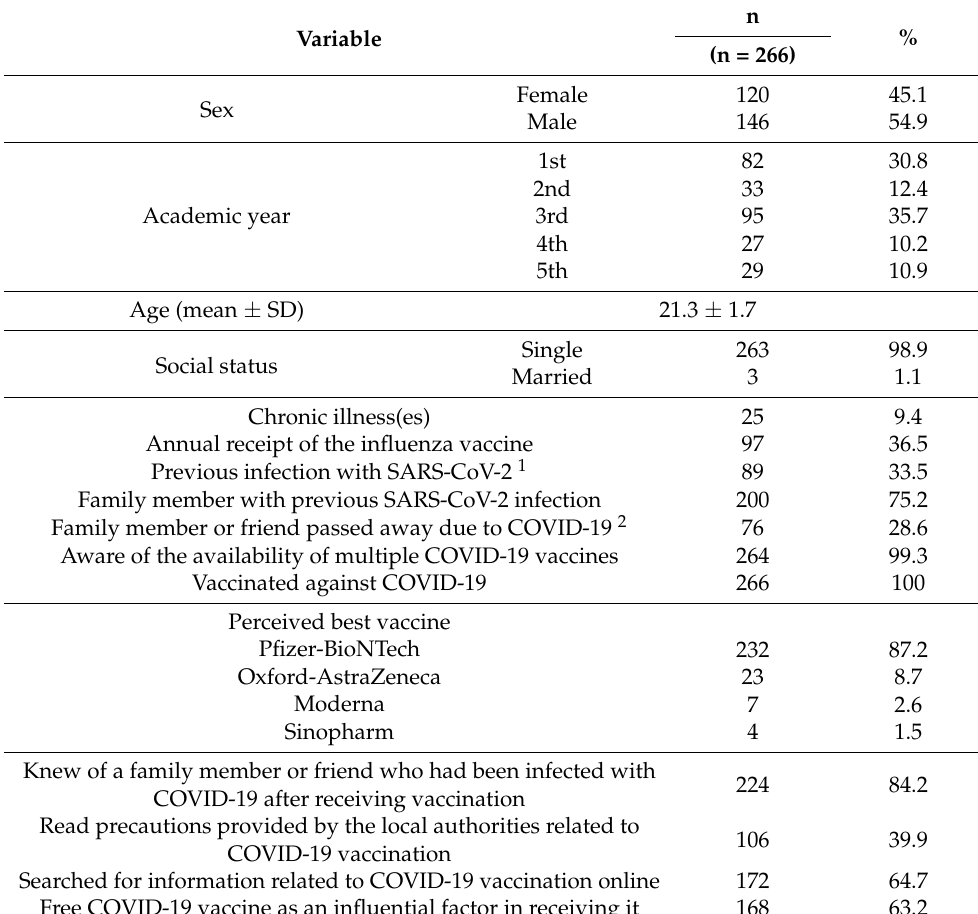
Table 2. Participant